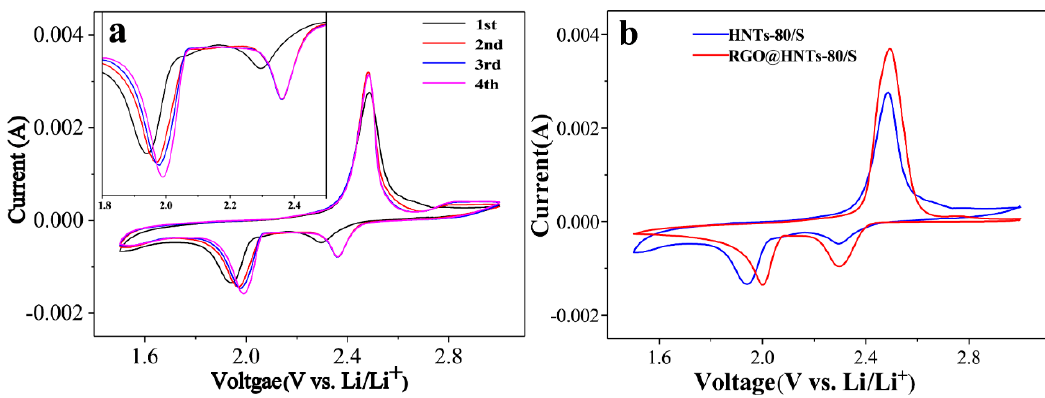
Figure 6. ( a ) Cyclic voltammetry (CV) curves of the HNTs-80/S cathode at 0.1 mV s − 1 scanning rate. Inset is the enlarged part of CV curves ranging from 1.8 V to 2.5 V; ( b ) Cyclic voltammetry (CV) curves of HNTs-80/S and RGO@HNTs-80/S cathode at 0.1 mV s − 1 scanning rate.